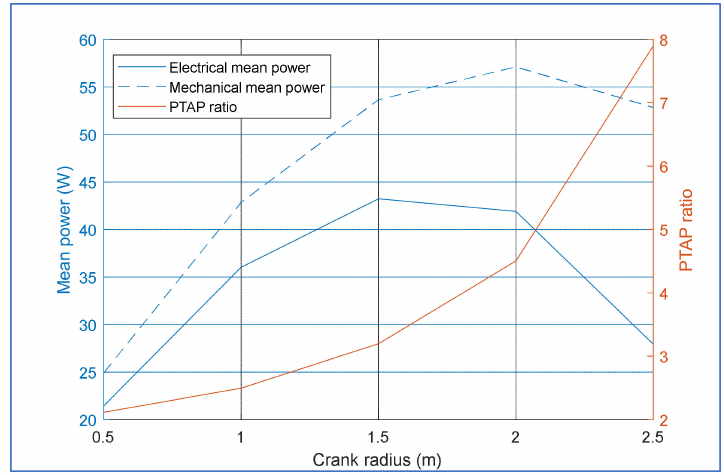
Figure 13. Variation of electrical and mechanical mean power, and PTAP ratio with arm length at l = 7.5 m.